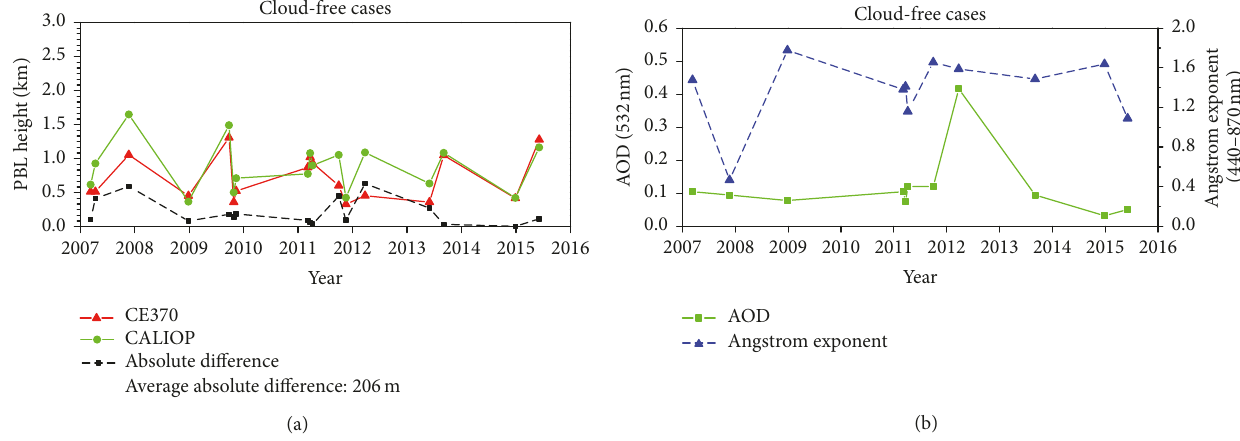
Figure 10: Under clear sky conditions, (a) illustrates the comparison of PBLH at the points of the nearest spatial and temporal coincidence between CALIOP footprints and CE370 Lidar site. (b) demonstrates the averaged AOD and ˚Angstr¨om exponent derived from the Sun Photometer within half an hour during CALIOP